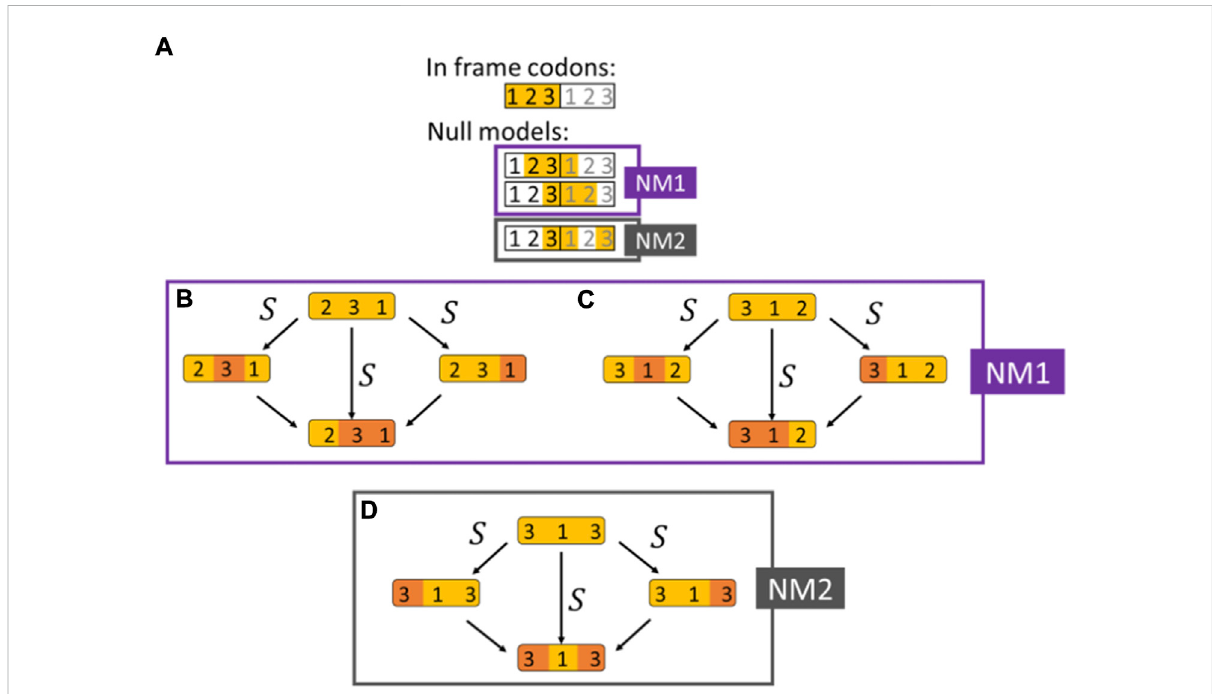
FIGURE 2 Double synonymous substitutions in adjacent codons used as null models. (A) The selection on double substitutions inferred bycomparing the DF for codons and their respective null models shown in orange (NM1 and NM2). Two adjacent codons are illustrated, and the nucleotide position within the codon is indicated according to the reading frame. The three null models are arti fi cial codons constructed by considering positions from two adjacent codons. (B) Null model NM1 (the 321 con fi guration). An invariant 2nd codon positions in the fi rst codon, followed by a 4-fold degeneratesiteinthe3rdpositionsofthe fi rstcodon,thatis,followedbya2-folddegeneratesiteinthe1stcodonpositionofthe2ndcodon. (C) Null model NM1 (the 312 con fi guration). A 4-fold degeneratesite inthe 3rd codon position followed bya2-folddegenerate site inthe 1stcodon position ofthesecond codon, that is, followedbyan invariant basein the2ndcodon position ofthesecond codon. (D) Null model NM2. A 4-fold degenerate site in the 3rd position of the 1st codon followed by an invariant 1st position in the second codon and by a 4-fold degenerate site in the 3rd codon position (skipping the 2nd position of the 2nd